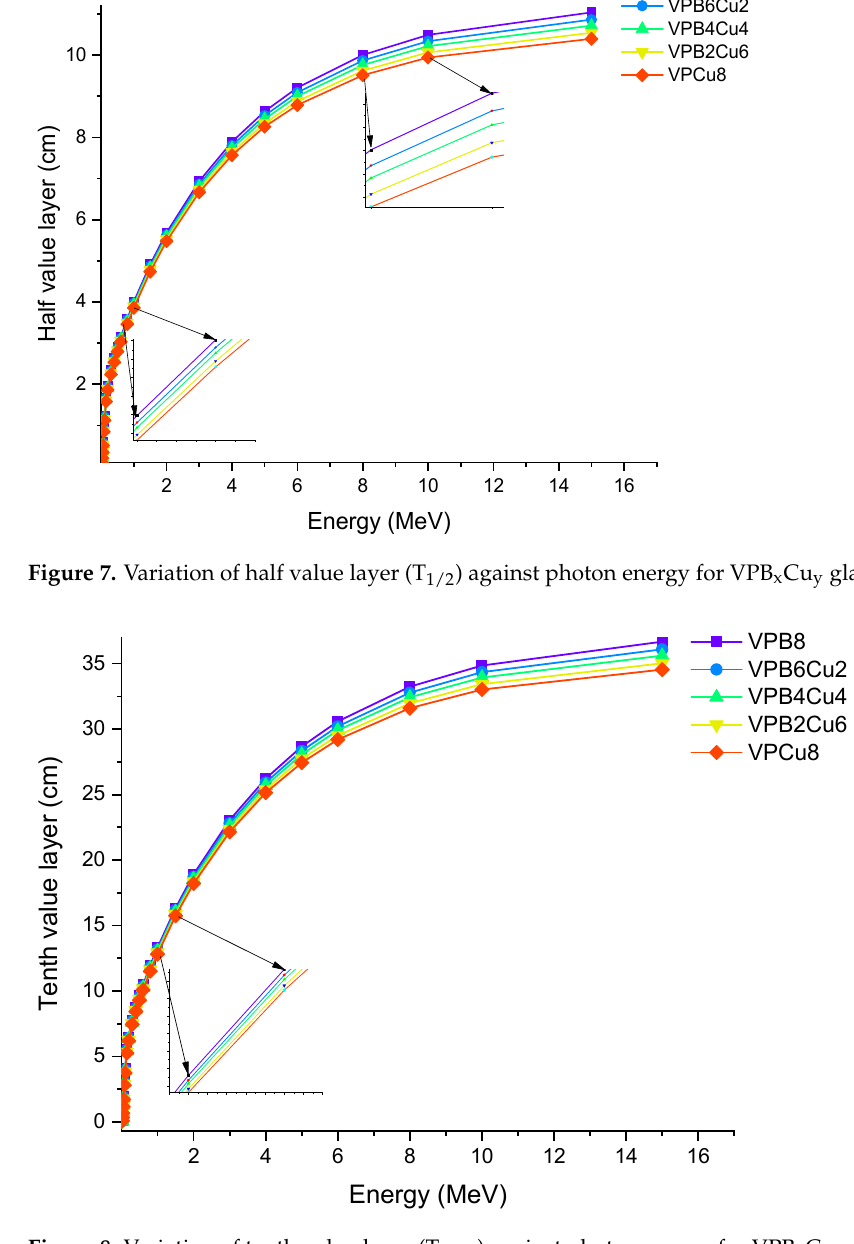
For the glass samples analyzed, a similar fluctuation pattern was observed with HVL.